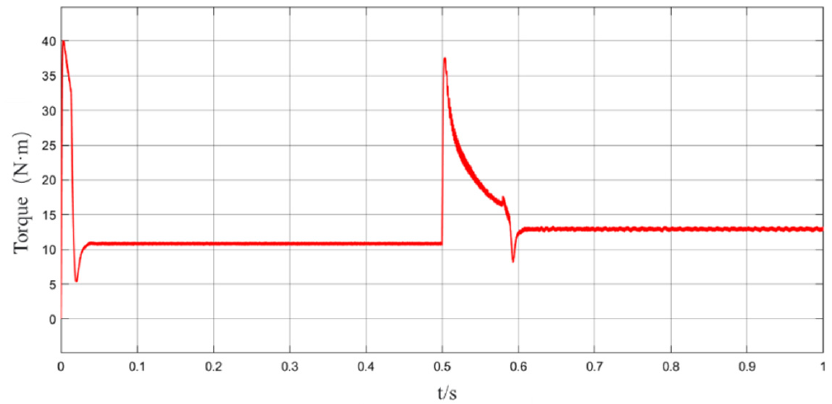
− MRAS Figure 21. Torque response curve of STSM − MRAS algorithm. Figure 21. Torque response curve of STSM Figure 21. Torque response curve of STSM − MRAS algorithm.